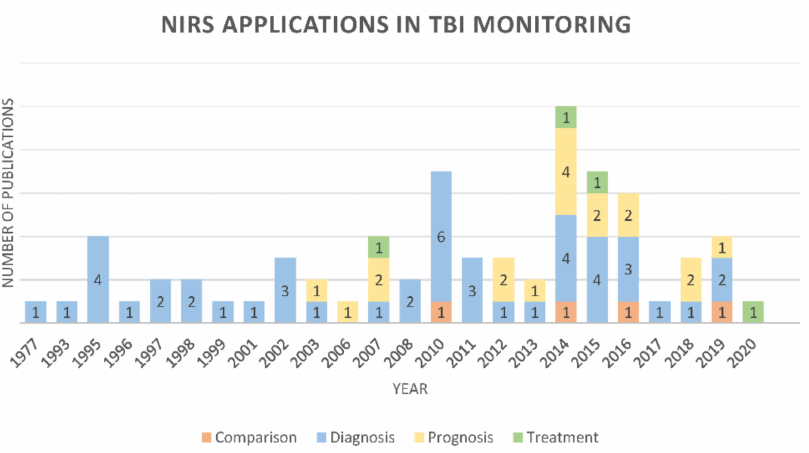
Figure 3. Number of publications per year associating TBI with the various types of NIRS applications.